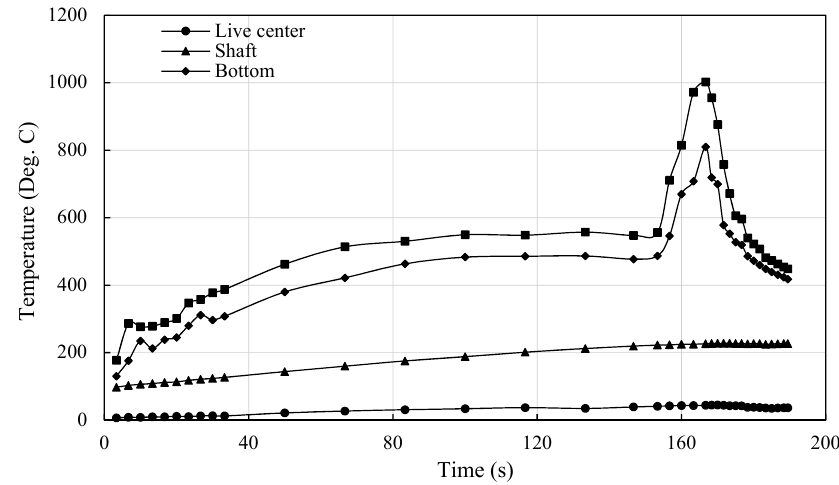
Figure 4. Typical variation of the measured temperatures during the heating process.